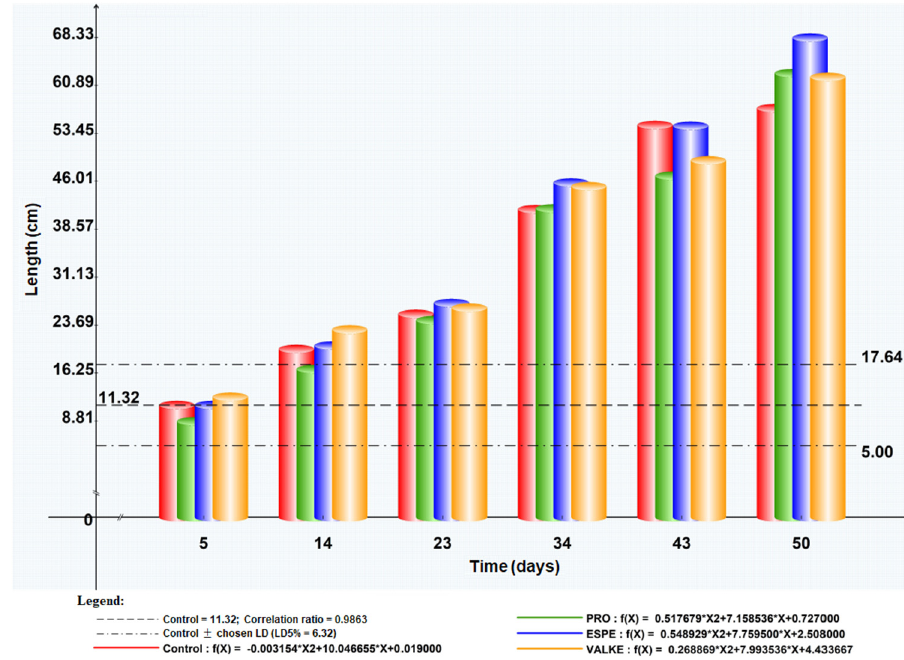
Figure 7. Maize plant length evolution after foliar fertilisation with keratin hydrolysates.